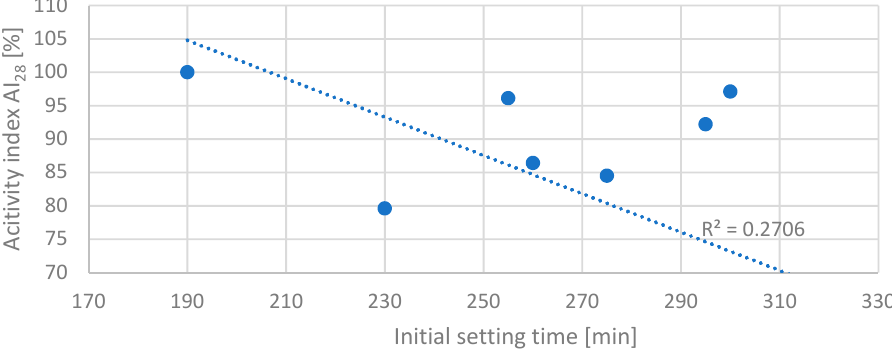
Figure 3. Dependence between initial setting time and activity index calculated in 28